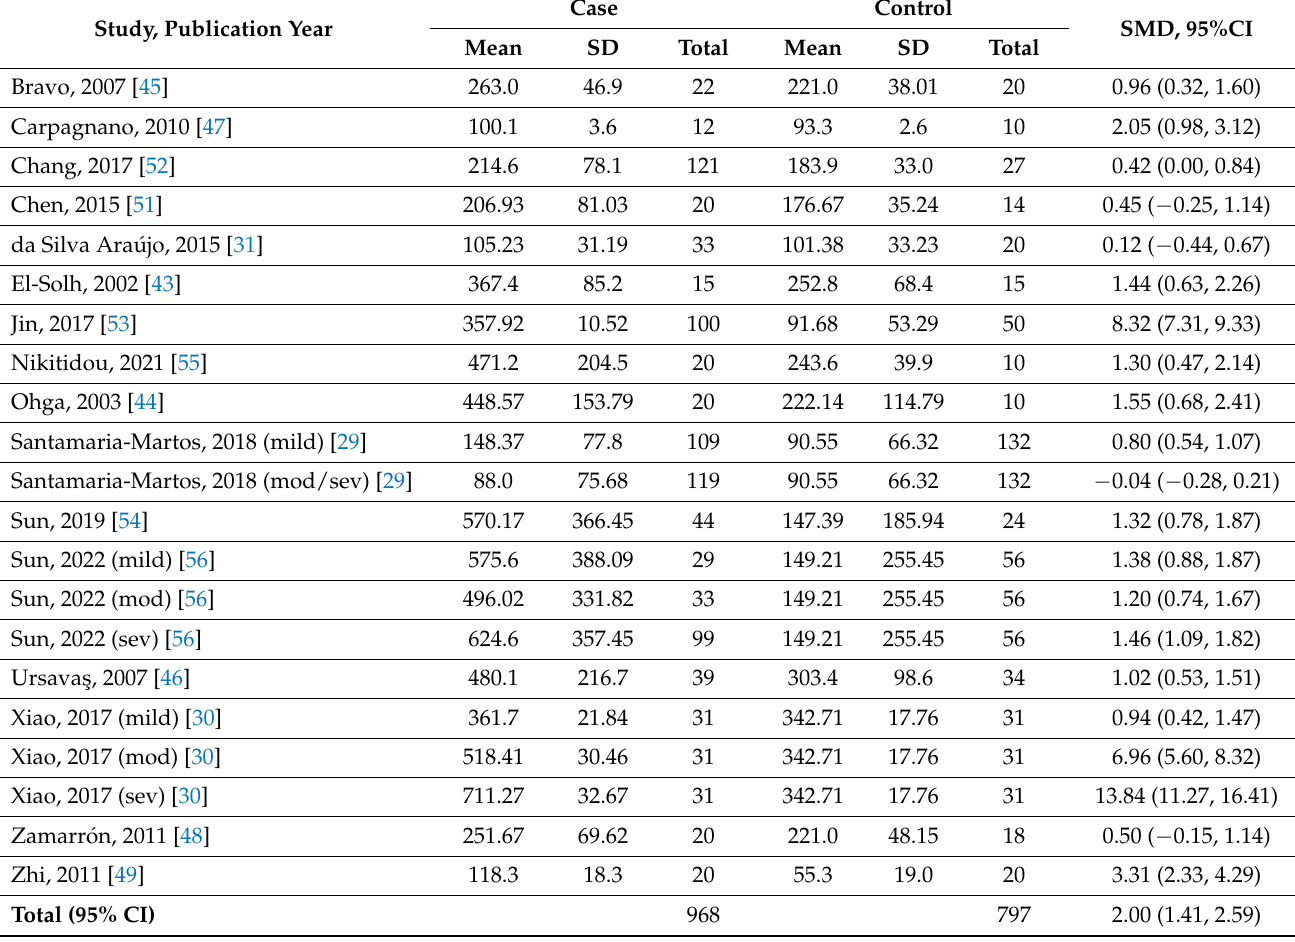
Table 2. Results of random-effects forest plot analysis. Serum/plasma intercellular adhesion molecule- 1 levels in adults with obstructive sleep apnea compared to